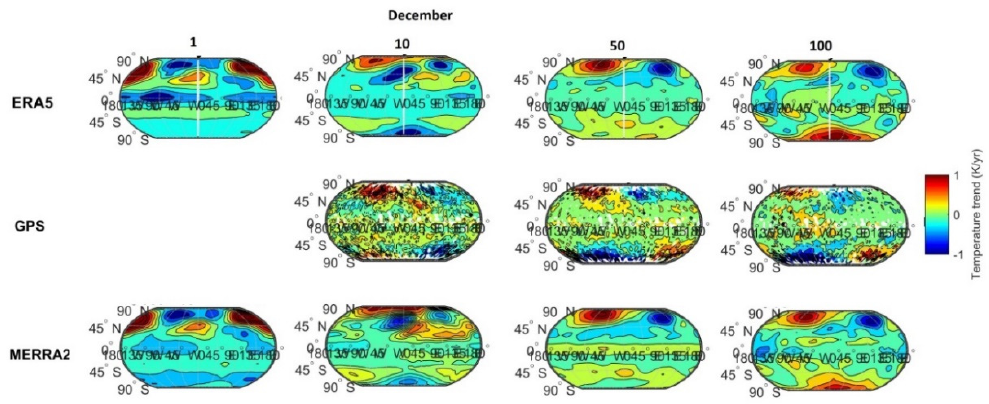
Figure 8. Temperature trends (K/dec) for December, period 2004–2018. ERA5 reanalysis on the top panels, GPS RO on middle panels, MERRA2 on the bottom panels for pressure levels 1, 10, 50, and 100 hPa.